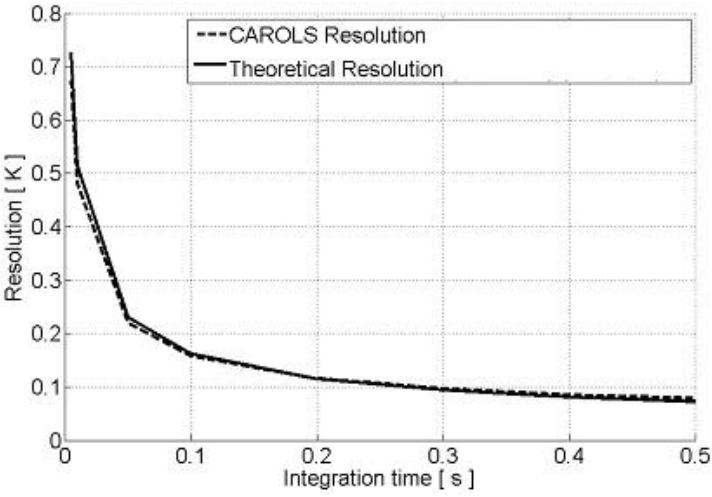
Figure 3. Radiometric resolution of the CAROLS radiometer.